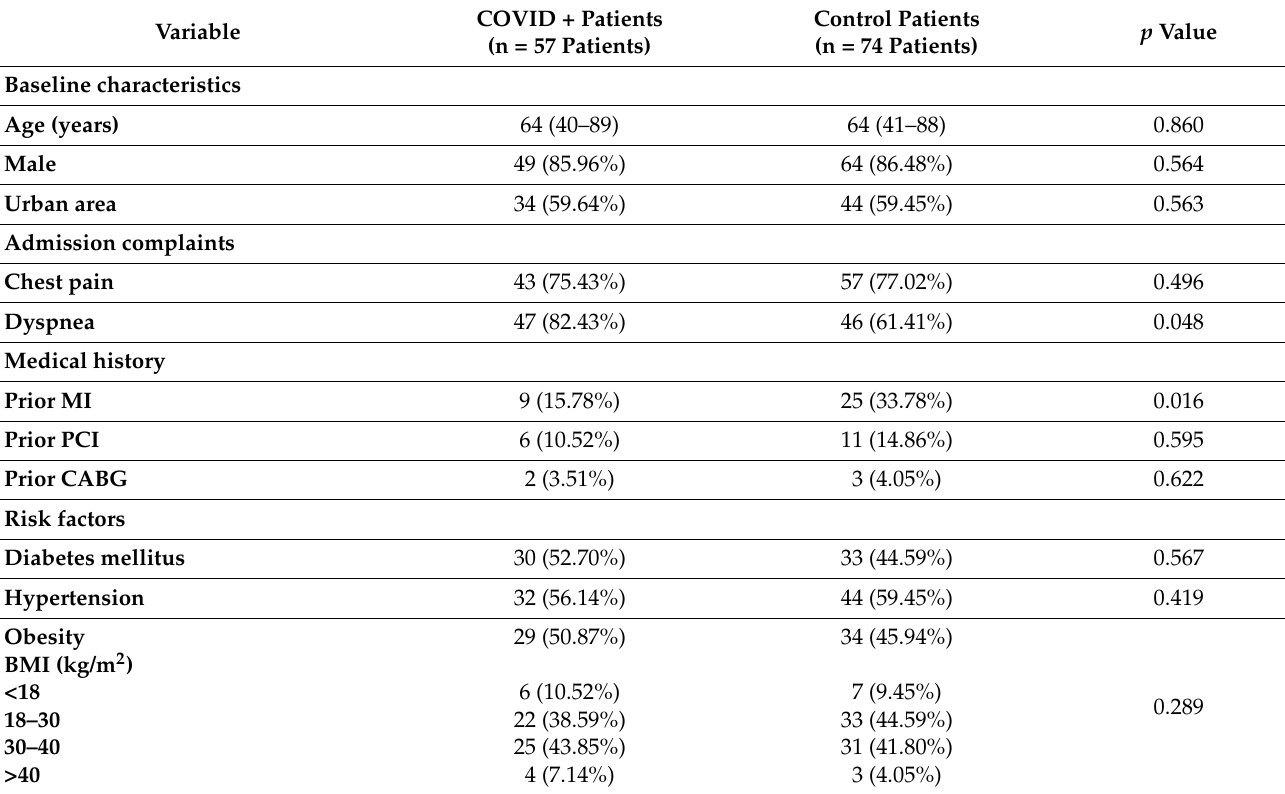
Table 1. Overview of baseline demographic and clinical